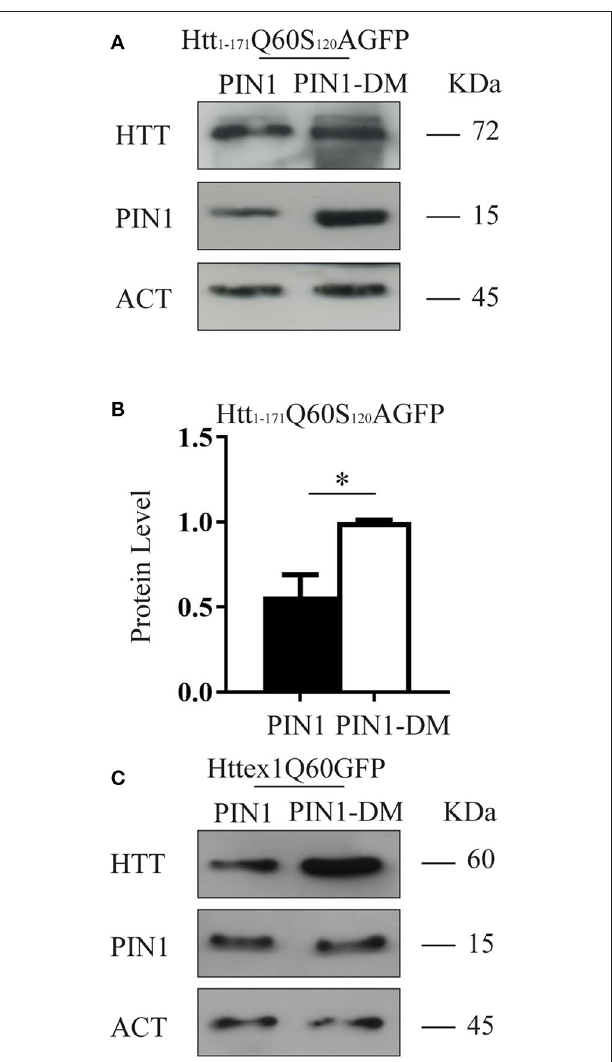
FIGURE 4 | PIN1 effect is not regulated through a direct interaction with HTT N-terminal fragments. HEK293 cells were co-transfected with HTT-encoding plasmids and HA-PIN1 or HA-PIN1DM. Cells were harvested for analysis 48h after transfection. (A) Representative western blot showing htt 1 – 171 Q60S120AGFP, PIN1 and β -ACTIN as loading control. (B) Relative protein level quantification of htt 1 – 171 Q60S120AGFP in the presence of PIN1 as compared to PIN1DM. (C) Representative western blot showing httex1Q60GFP, PIN1, and β -ACTIN as loading control. Data are the mean ± SD from 3 independent experiments. * P < 0.05. Asterisk indicates the statistically significant difference in the level of protein.